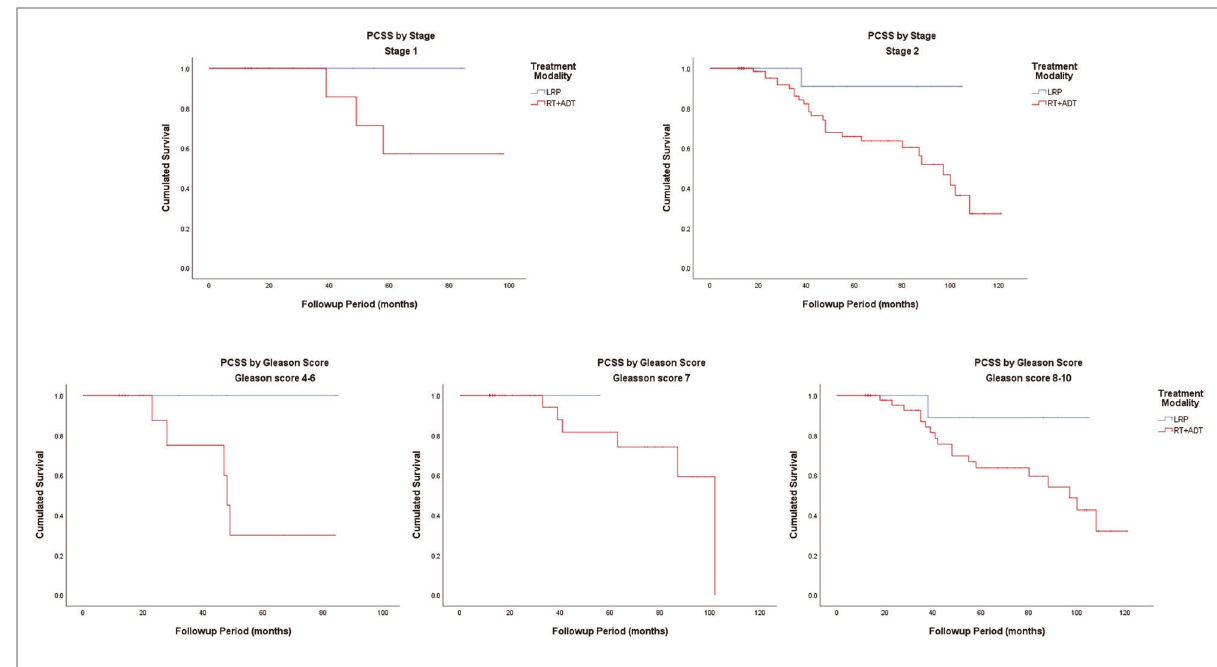
FIGURE 3 Prostate cancer-speci fi c survival by stage and Gleason score.